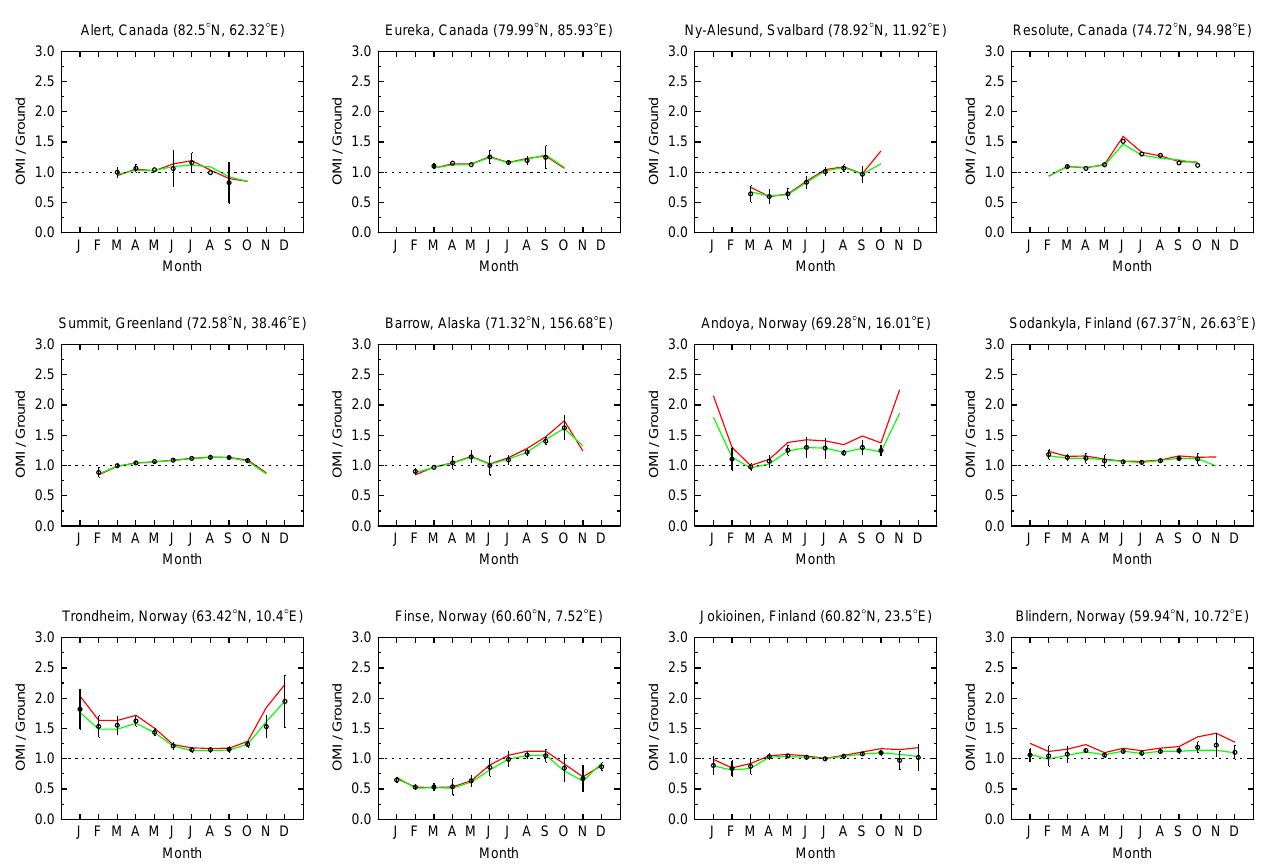
Figure 6. Comparison of ¯ ρ 4 (red lines), e ρ 4 (green lines), and ¯ R 4 (open circles). The error bars indicate ± σ 4 . Data used for this figure were not filtered for SZA and Dis because such filtering would have reduced the number of data points of ¯ R 4 substantially. Values of ¯ ρ 4 and e ρ 4 are therefore slightly different from those indicated in Fig.